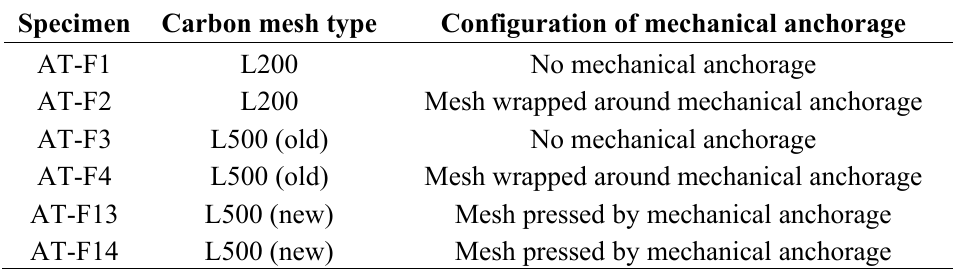
Table 6. Tested configurations of retrofitted masonry elements in Series